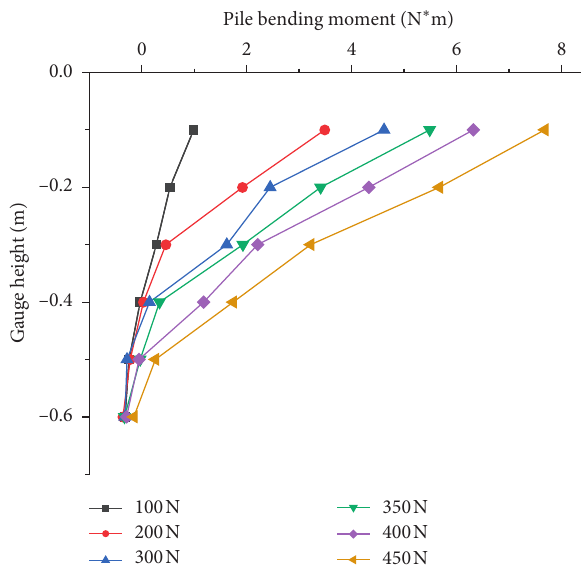
Figure 17: Curve of bending moment of positive inclined pile loaded in the reverse direction of y .